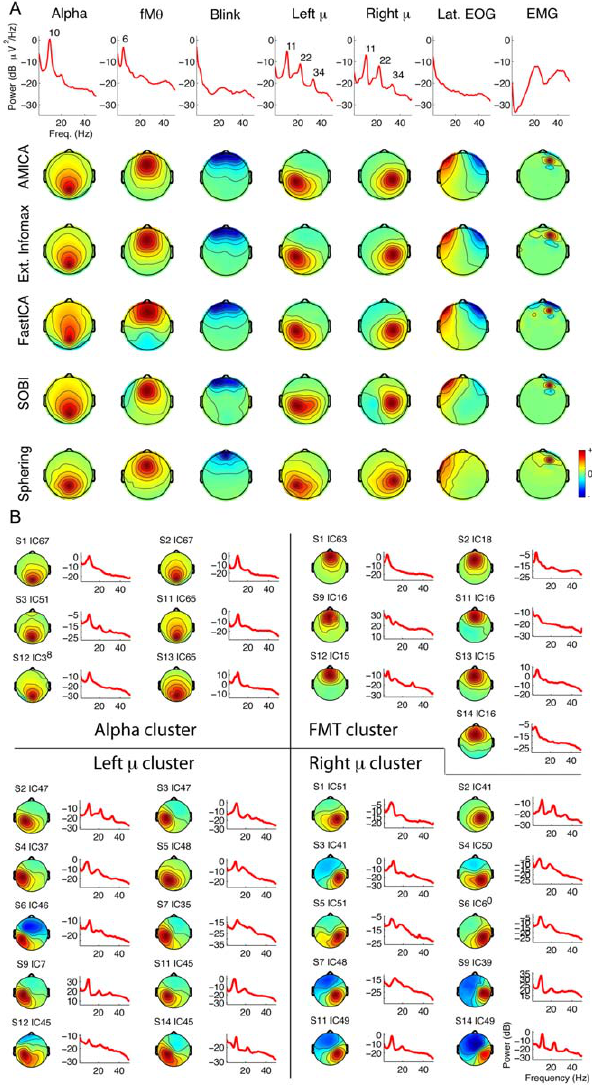
Figure 2. ICA algorithms return similar dipolar components. A . The top rows show activity spectra and scalp maps for seven AMICA components from one subject accounting respectively for eye blinks, lateral eye movements (EOG), and right frontal scalp muscle activity as well as posterior alpha band, central mu rhythm, and frontal midline theta activity. Lower four rows show scalp maps of best-matching components by Extended Infomax ICA, FastICA, SOBI, and sphering decompositions of the same subject data, e.g., those with highest absolute scalp map correlations to the respective AMICA components. Note the resemblance of the scalp maps in each case for AMICA and Extended Infomax, and the differences between the AMICA and sphering component maps. B . Scalp maps and mean activity spectra of four clusters of similar AMICA components from 6–10 different data sets from different subjects, isolated by visual inspection of component scalp maps and mean activity spectra and accounting respectively for central occipital alpha, frontal midline theta, and left and right mu rhythm activities.